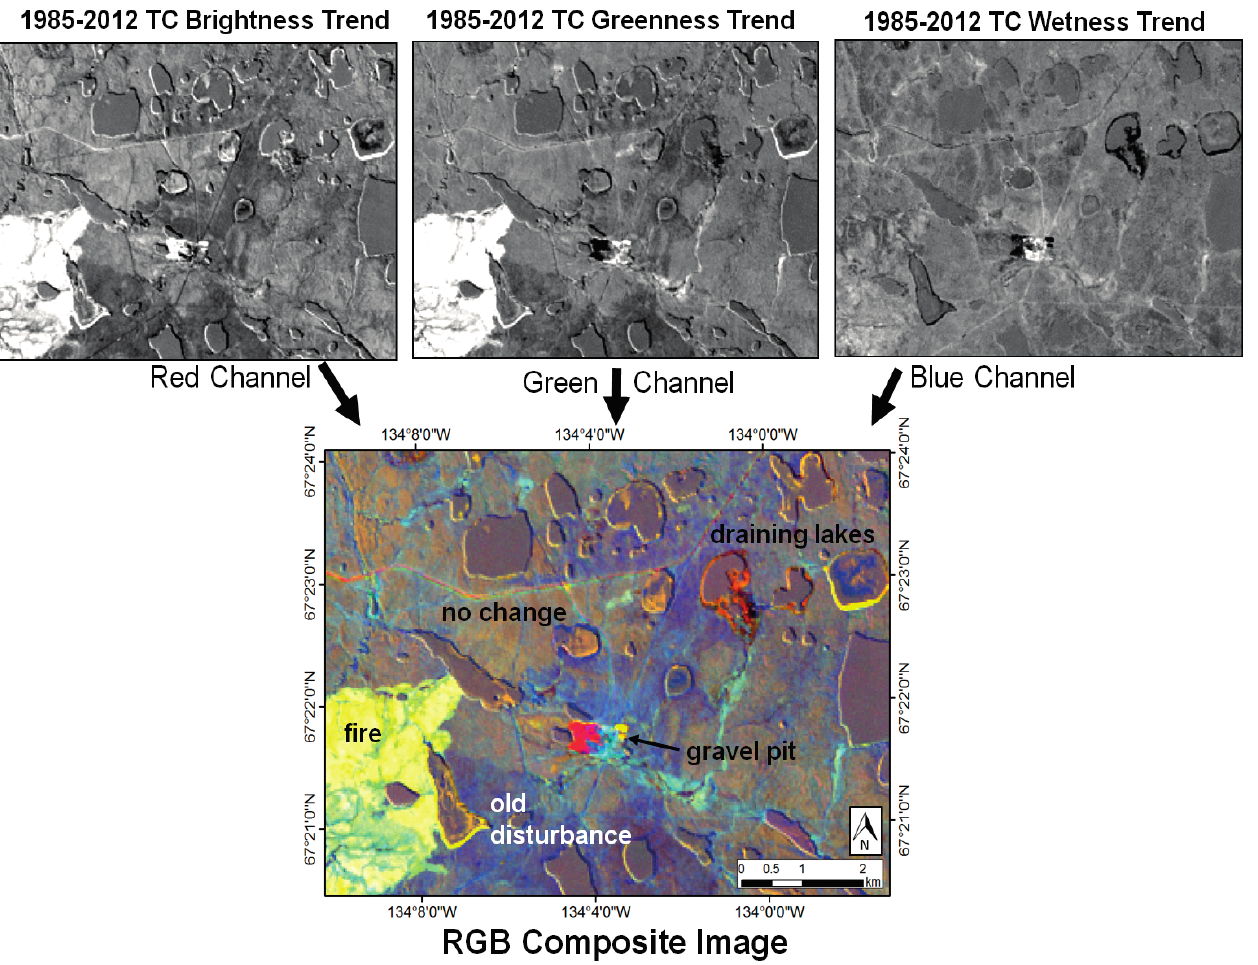
Figure 2. Tasseled Cap (TC) trend compositing method used by LARCH. Individual trend (slope) images from linear regression analysis of the Landsat image stack are composited as an RGB image to yield unique colors representing the three-dimensional TC